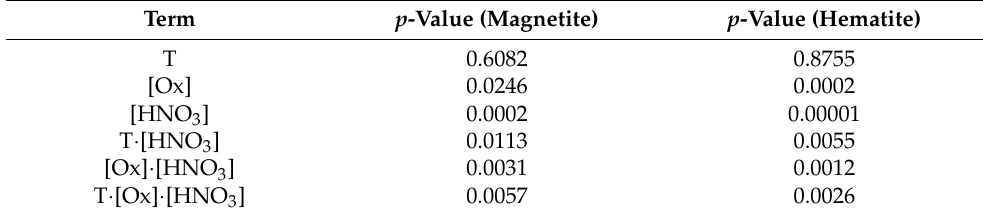
Table 2. p -values of each variable in linear model with interaction terms.